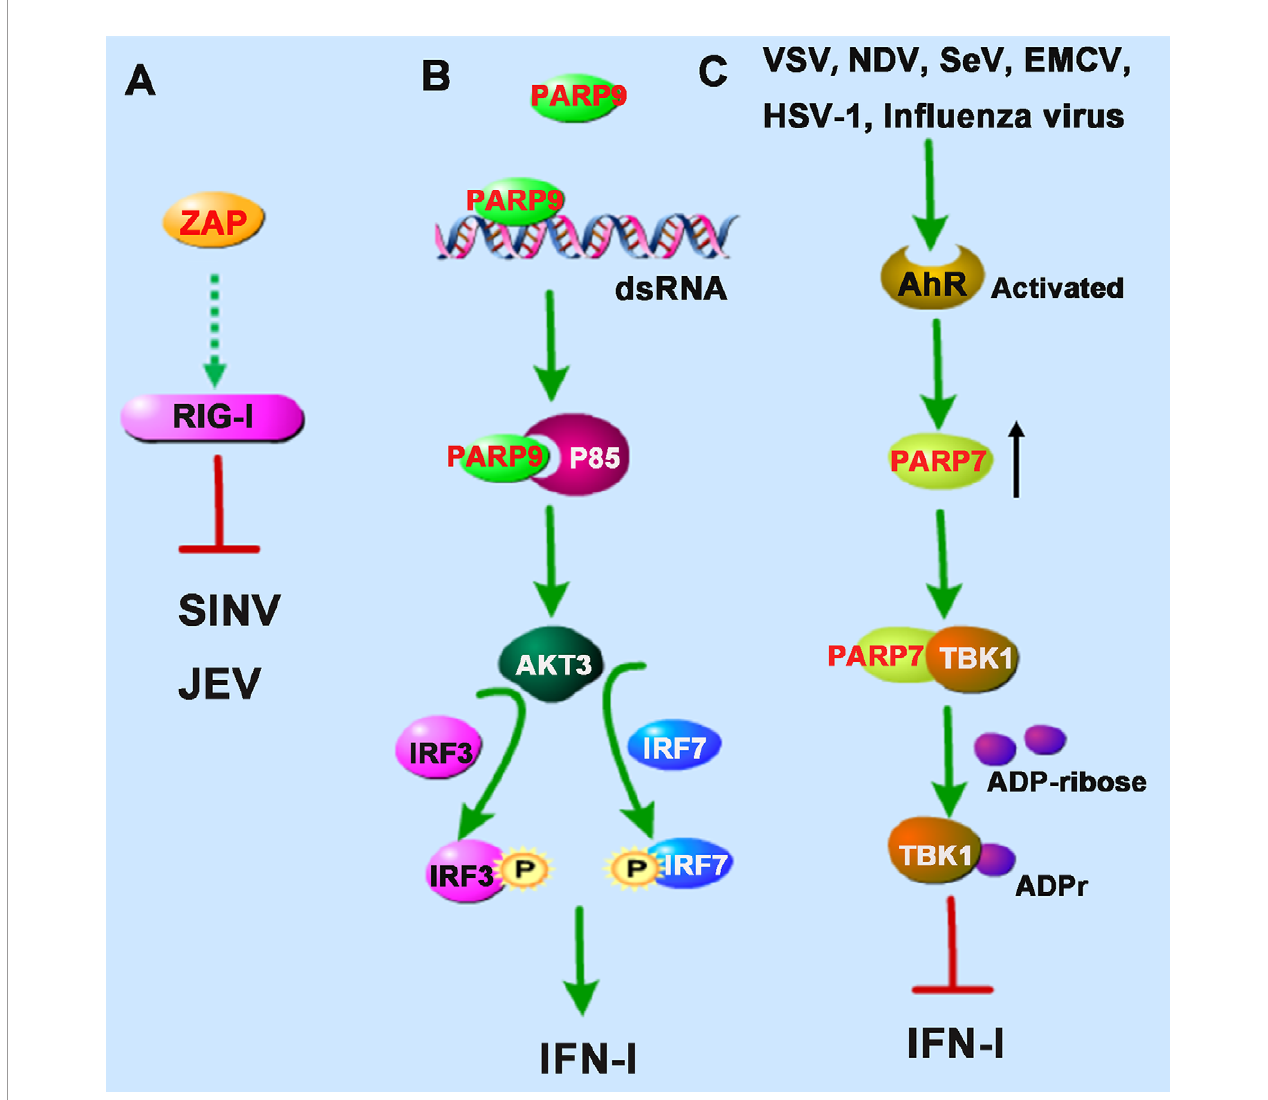
FIGURE 2 | PARPs regulate the RNA sensors-mediated antiviral innate immune responses. (A) ZAP inhibits Sindbis virus (SINV) and Japanese encephalitis virus (JEV) probably by enhancing the RIG-I signaling pathway. (B) PARP9 recognizes and binds to dsRNA from reovirus or poly(I:C) and subsequently binds to and activates the PI3K regulatory subunit p85, and then further triggers the downstream AKT3 activation to phosphorylate IRF3 and IRF7 for IFN-I production. (C) The infection of vesicular stomatitis virus (VSV), in fl uenza virus, Newcastle disease virus (NDV), Sendai virus (SeV), encephalomyocarditis virus (EMCV), or herpes simplex virus-1 (HSV-1) could activate the aryl hydrocarbon receptor (AhR), which subsequently upregulates the expression of PARP7. PARP7 physically interacts with TBK1 and inhibits its activity by ADP-ribosylation, abolishing the antiviral IFN-I signaling pathway. Dashed lines indicate uncertain interactions or that the underlying mechanism is not